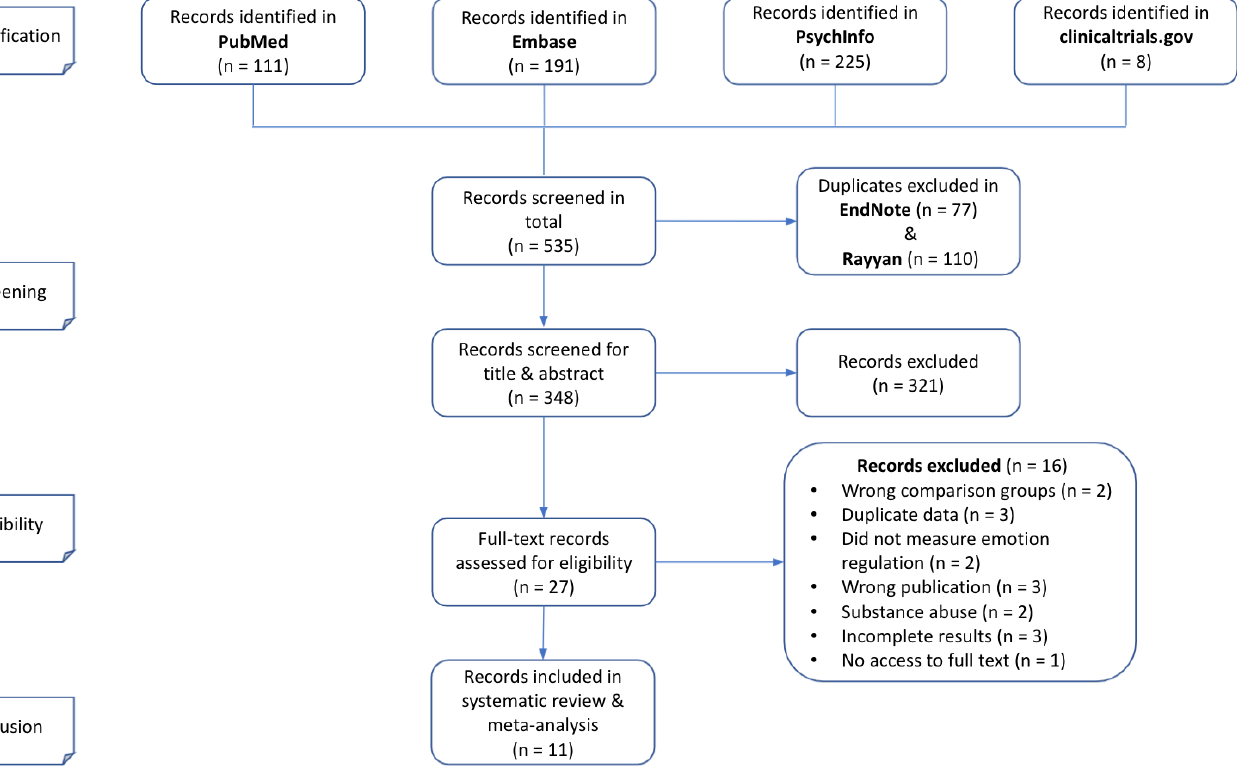
Figure 1. Prisma flow diagram of the current